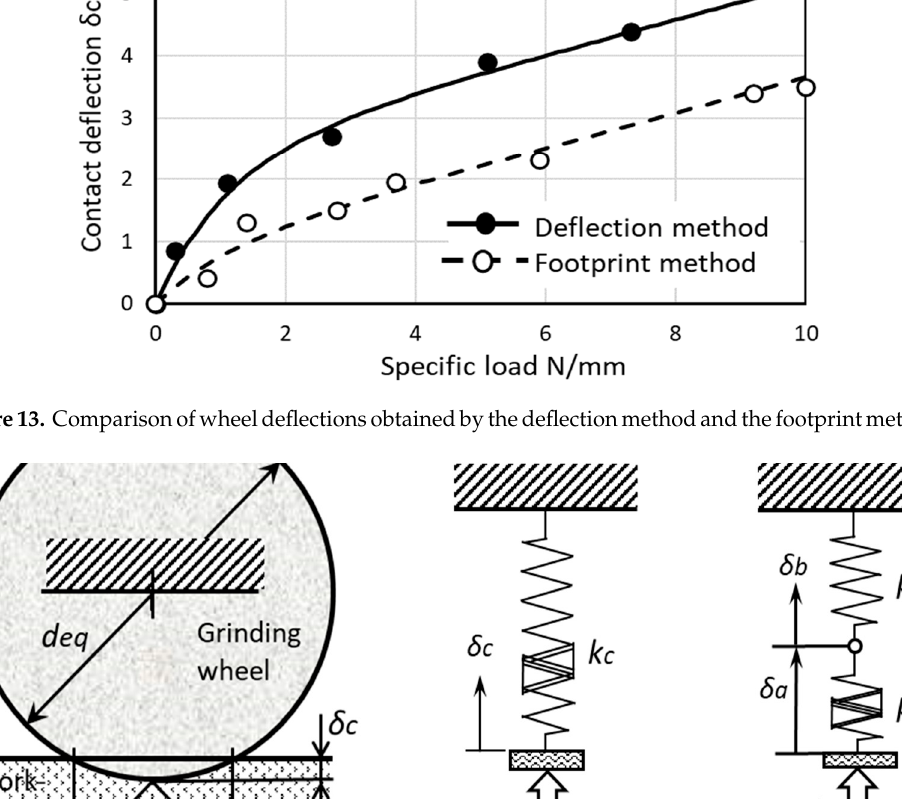
Figure 13. Comparison of wheel deflections obtained by the deflection method and the footprint method.